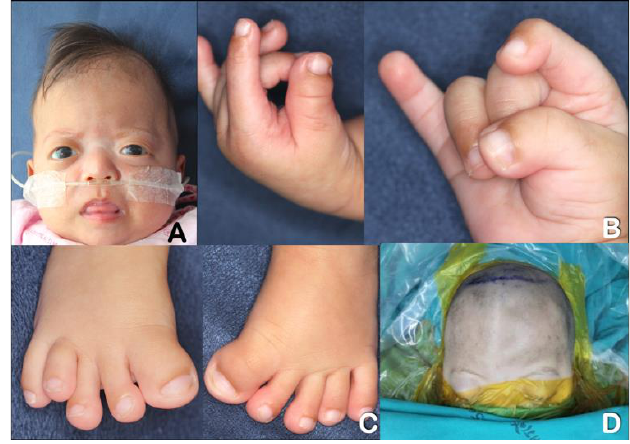
Figure 2. Twin B at age 3.5 months. ( A ) Brachydactyly, ocular proptosis, and depressed nasal bridge. ( B ) Brachydactyly and broad thumbs. ( C ) Broad great toes. ( D ) Preoperative view of the cranium. Note ridge at metopic suture as a result of synostosis.